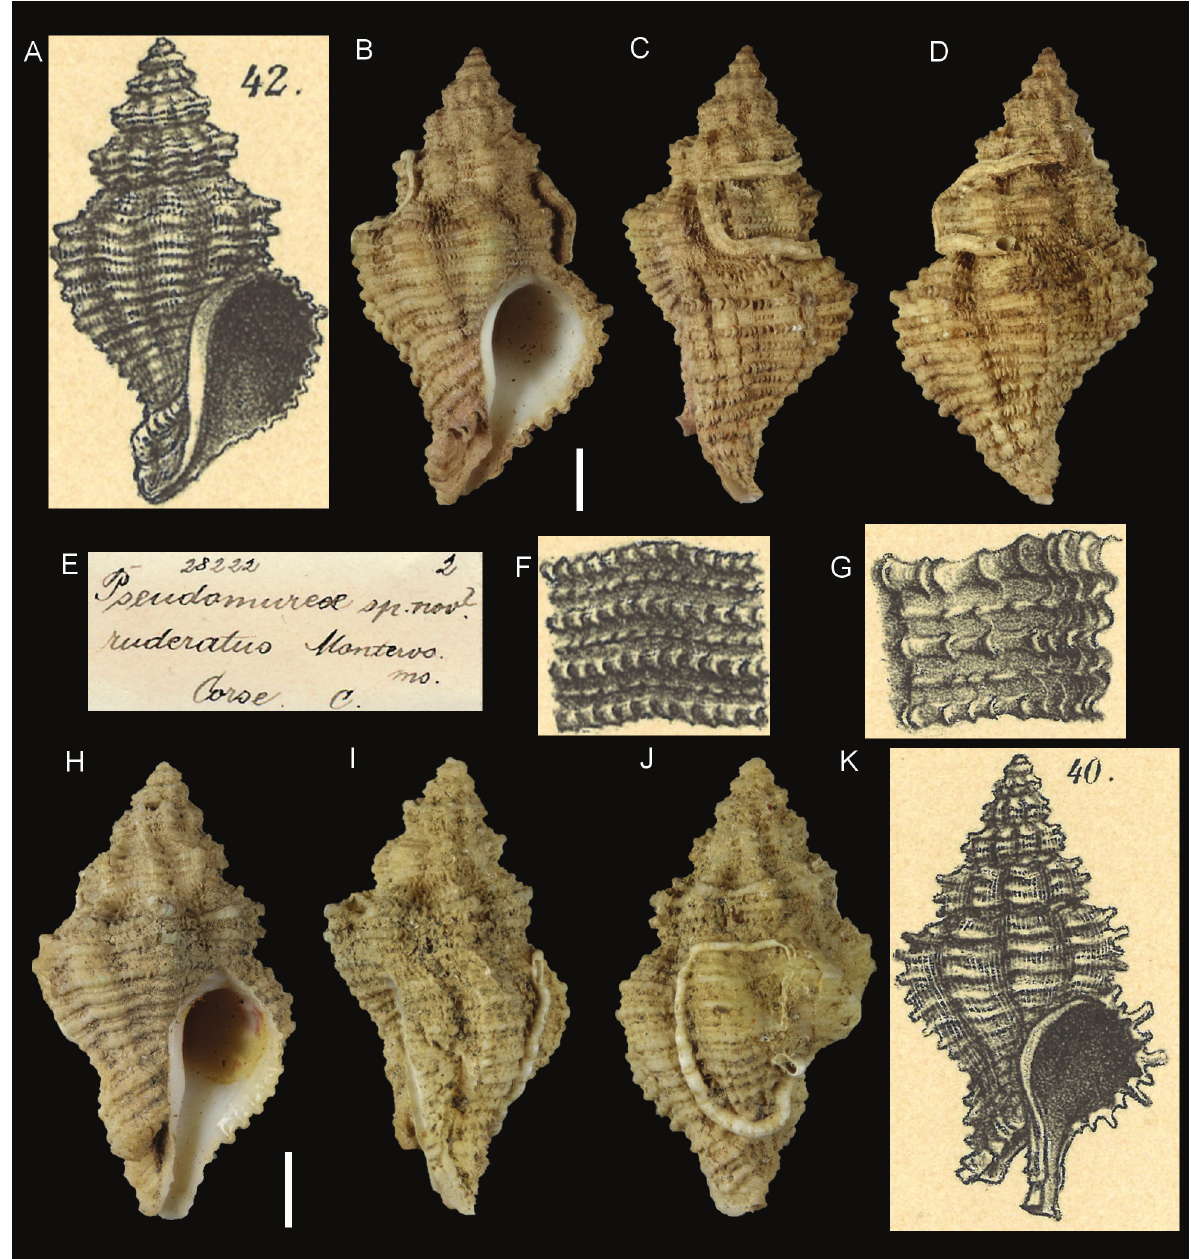
Figure 4. A–F , H–J . Pseudomurex ruderatus Sturany, 1896 in Monterosato ms., Corsica, France. Original figures in Sturany, 1896 ( A , I ). Specimen NHMW 28222a: front ( B ), side ( C ) and back ( D ) views, original label ( E ). Specimen NHMW 28222b: front ( H ), side ( I ) and back (J) view. G , K . Fusus craticulatus var. pianosana Sturany, 1896, Station 243, between Tremiti Islands and